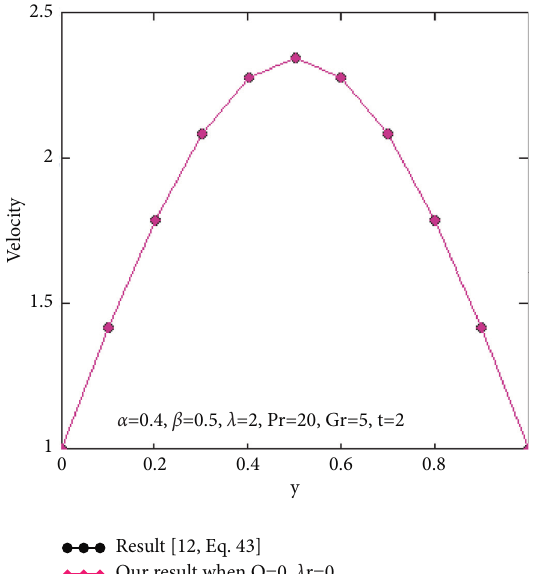
Figure 16: Velocity profiles of our models compared with the velocity profile of [12] f